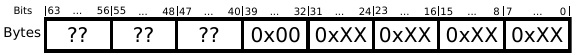
Figure 11. Illustration which bytes, and in which way these bytes of a vulnerable pointer must be modified, for the exploit to succeed with